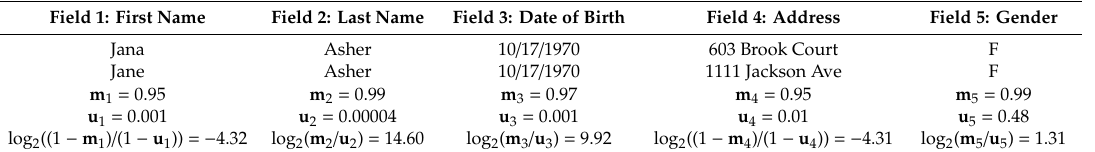
Table 1. Pair of records compared during a probabilistic record linkage process. In this case, overall match weight, based on three matched fields and two non-matched fields, is